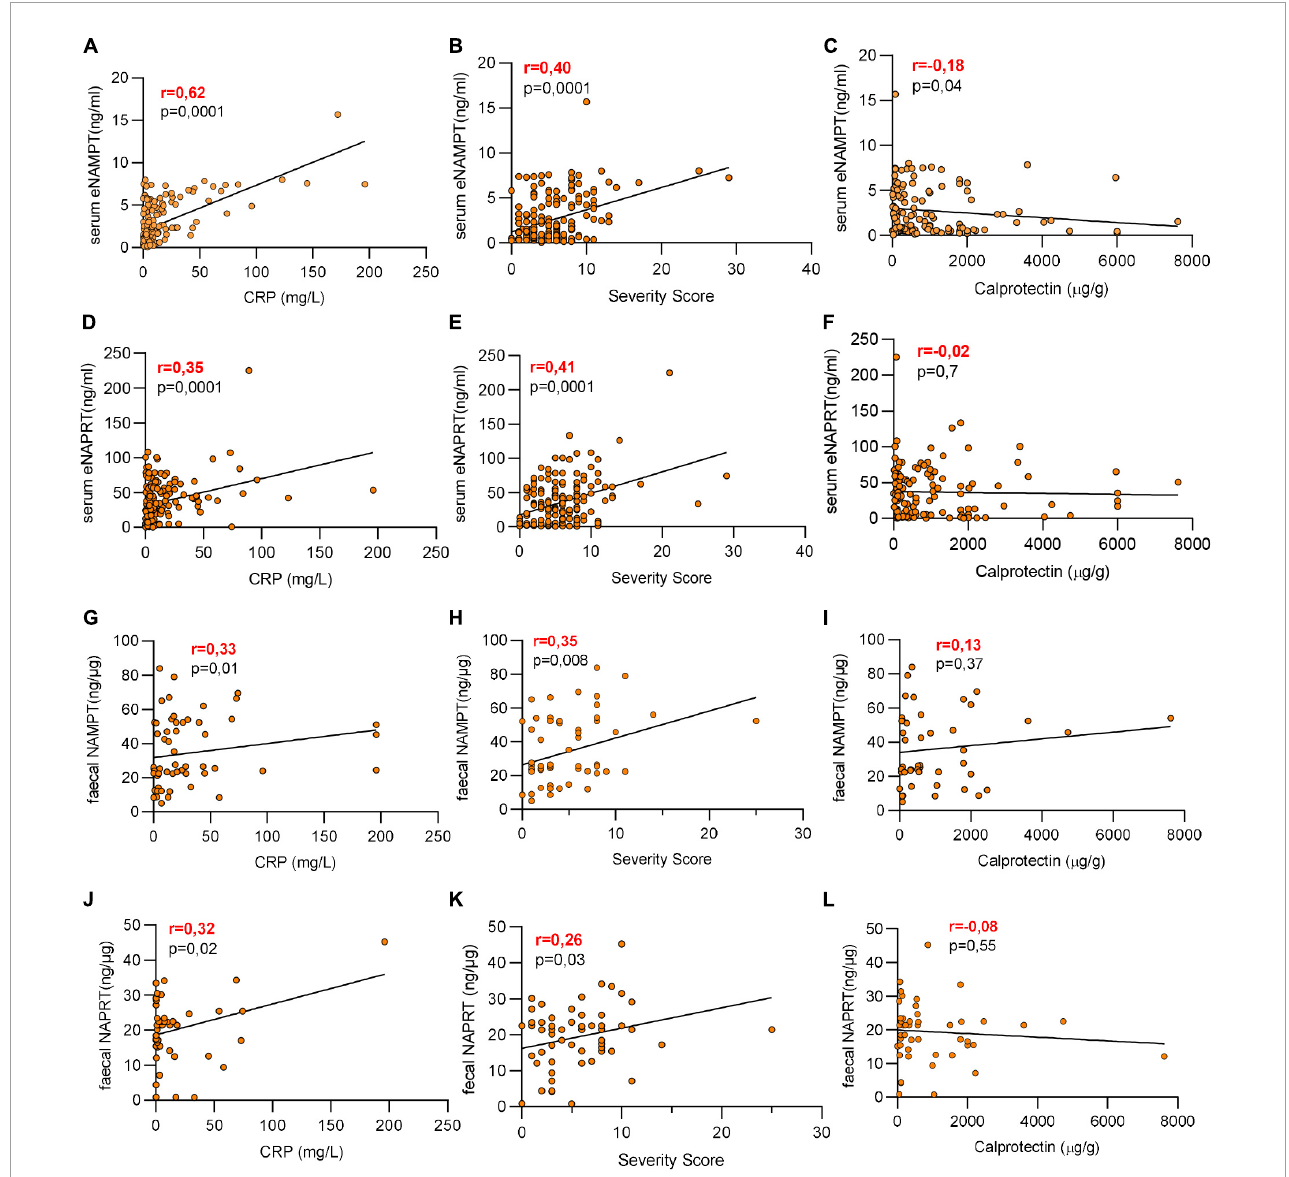
FIGURE2 Serum and faucal eNAMPT and eNAPRT are positively correlated with hsCRP and the pathological score. (A–F) Pearson correlation between serum eNAMPT or eNAPRT and (A,D) hsCRP levels, (B,E) pathological score and (C,F) calprotectin in IBD patients (healthy controls N = 18: CD n = 128; UC = 52). (G–L) Pearson correlation between faucal NAMPT or eNAPRT and (G,J) hsCRP levels, (H,K) pathological score and (I,L) calprotectin in IBD patients (healthy controls N = 18: CD n = 40; UC =